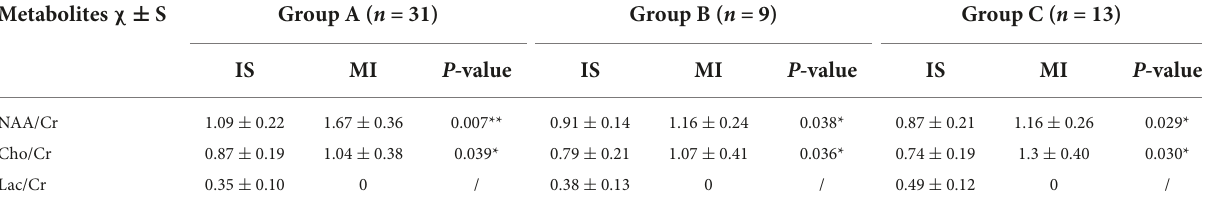
TABLE 3 Characteristics of metabolites following brain infarct for the three groups.